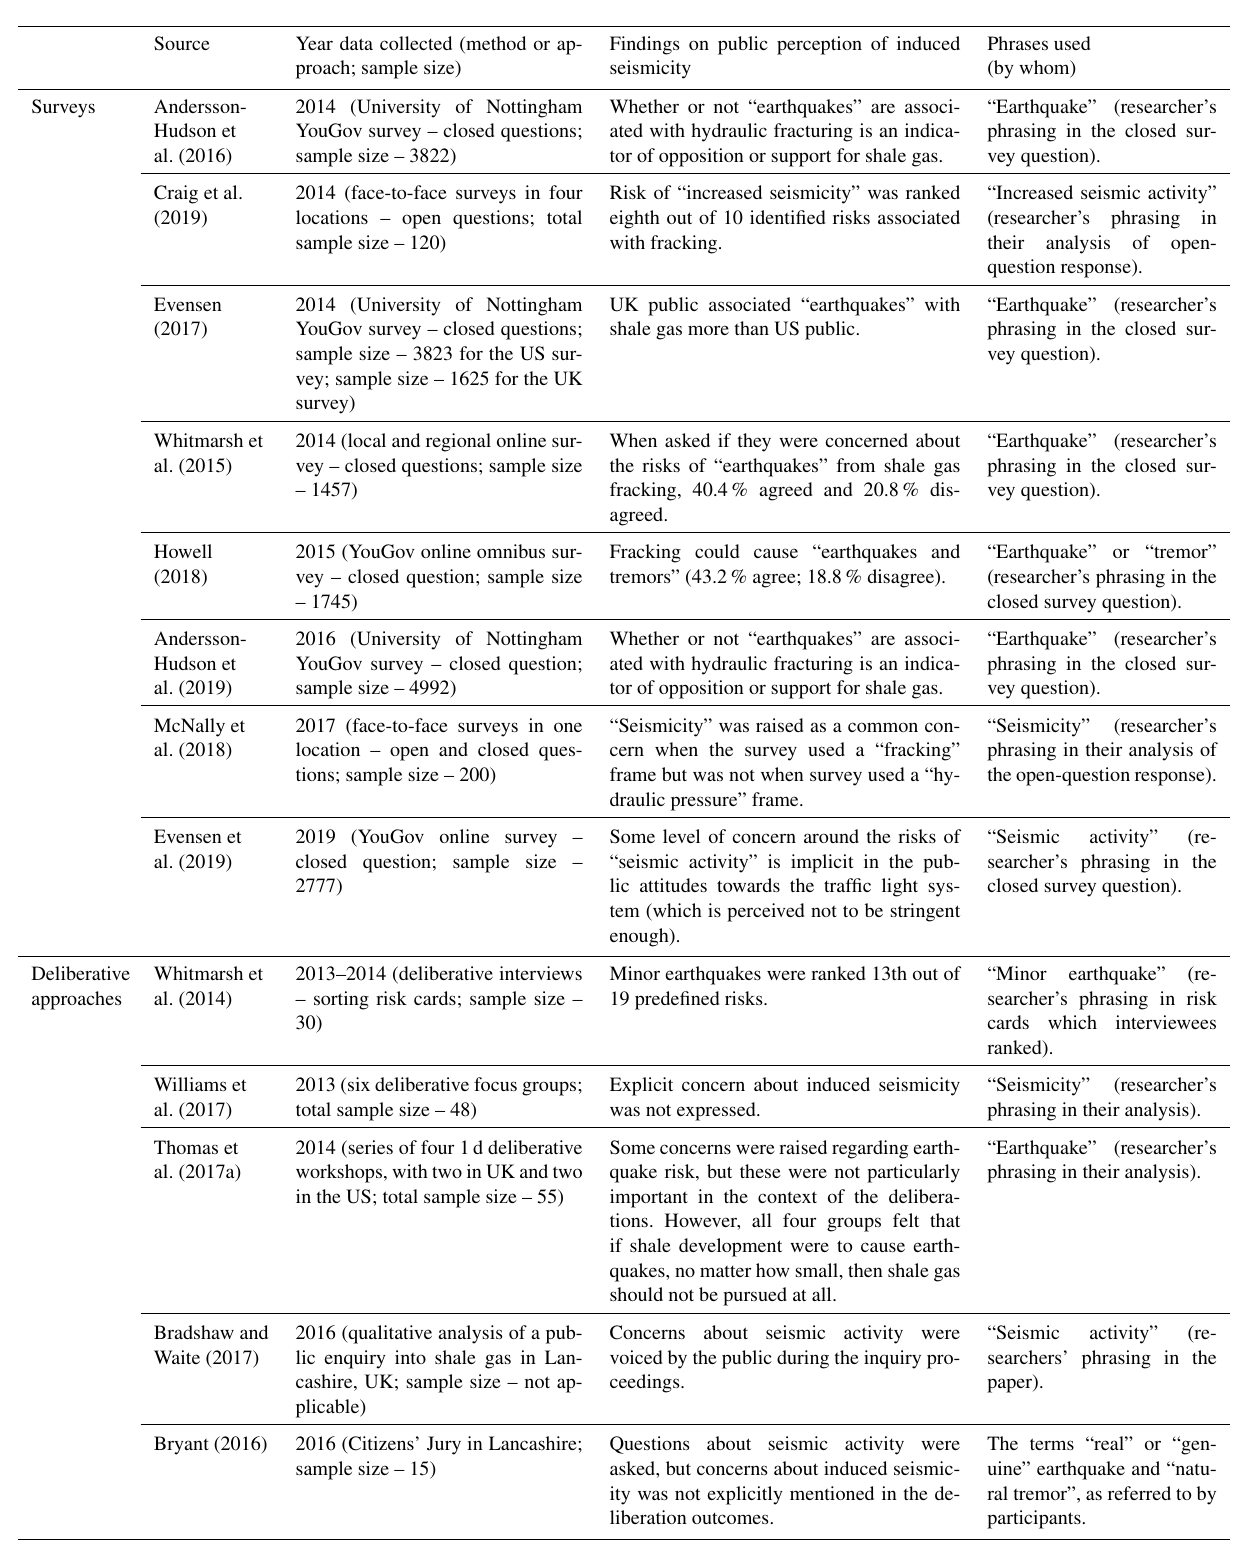
Table 2. A compilation of published studies which report on public perceptions of induced seismicity in the UK. These are divided into surveys (many of them UK-wide) and more qualitative approaches, such as focus groups, and each group is ordered chronologically in terms of when the data were gathered (not in terms of when the papers were published). We identified whether the phrasing used to describe seismic events was dictated by the language of the survey questions, the researcher undertaking the analyses, or the participants